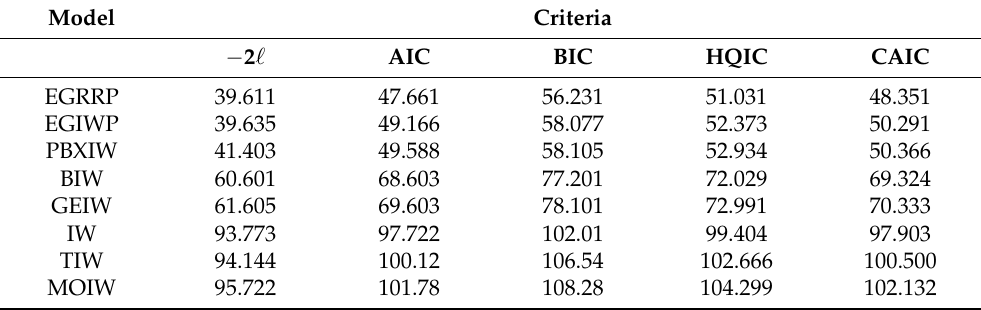
Table 11. − 2 (cid:96) , AIC, BIC, HQIC, and CAIC for the 2 nd dataset.